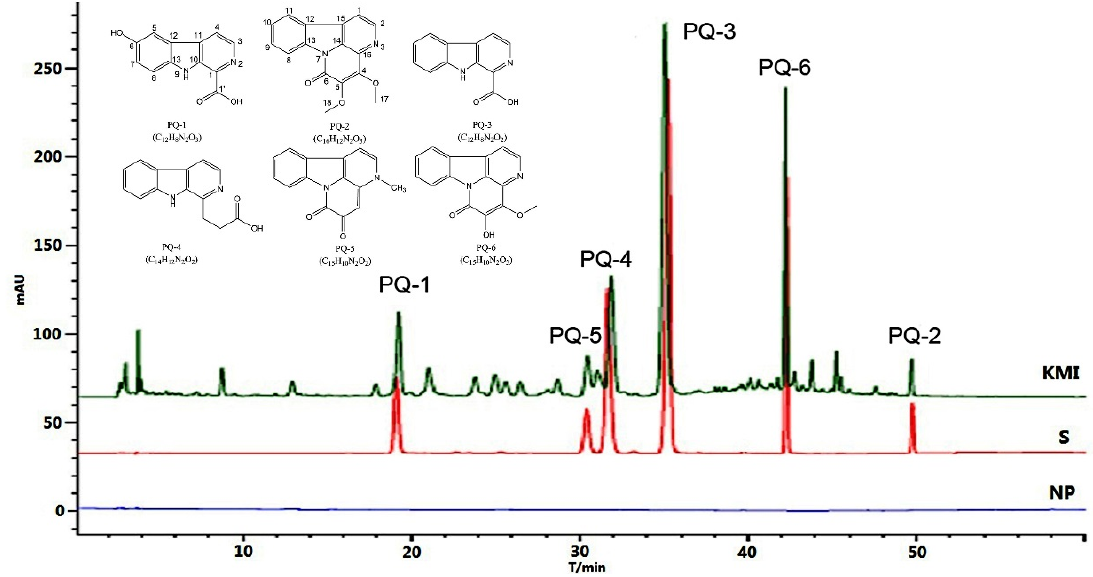
Figure 1. Chromatograms of Kumu injection (KMI) and the mixture of six reference standards. NP: the negative preparation; S: reference standards.